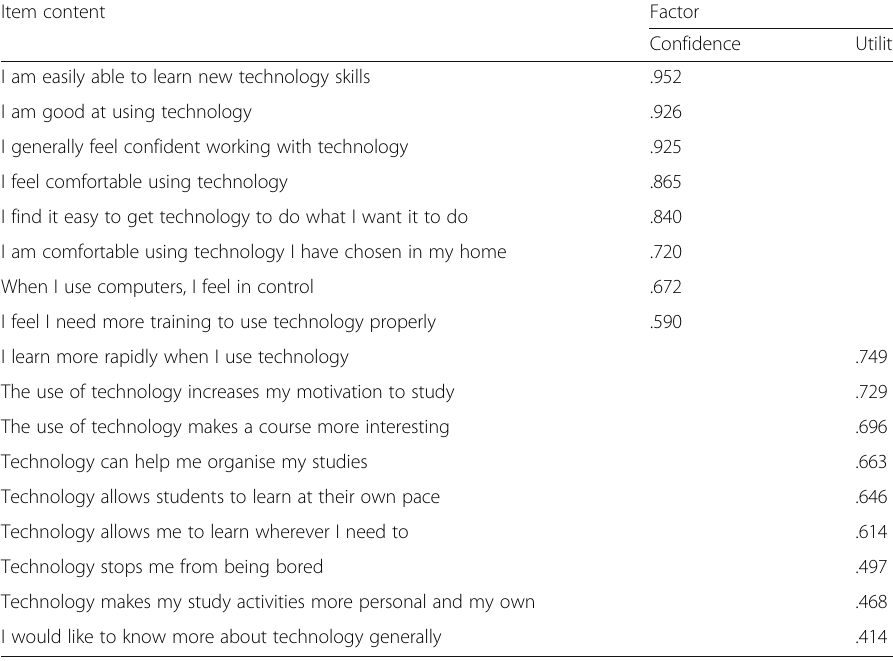
Table 3 Factor structure of students ’ attitudes to technology Item content